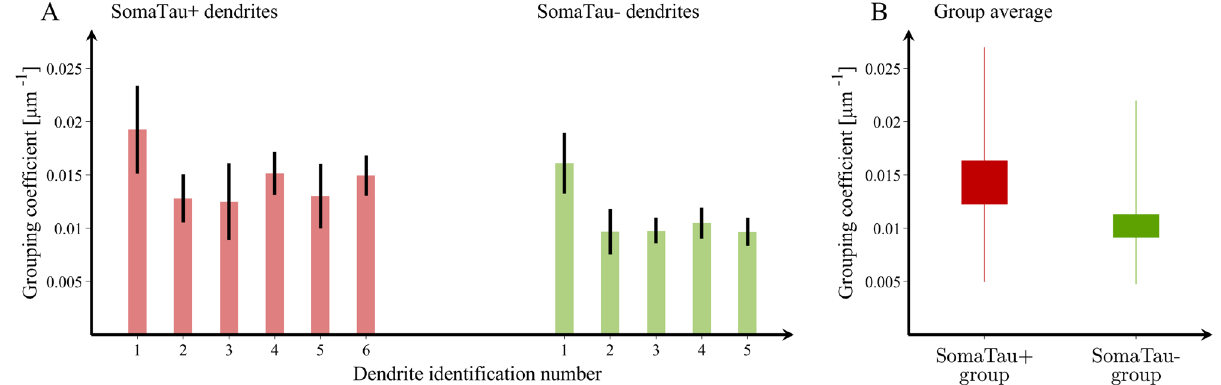
Figure 4. Mean grouping coefficient in dendrites with and without tau pathology. ( A ) Mean grouping coefficient in each single SomaTau + (n = 6; red) and SomaTau- (n = 5; green) dendrite. Boxplots with the mean grouping coefficients in the SomaTau- and SomaTau + dendrites. ( B ) The permutation analyses show a higher mean grouping coefficient in the Tau + compared to the Tau- group ( p < 0.001). In all boxplots, their bottom and the top edges denote the 25th and 75th percentiles of the data, respectively. The whiskers extend to the largest and smallest data points. The results are similar after excluding the